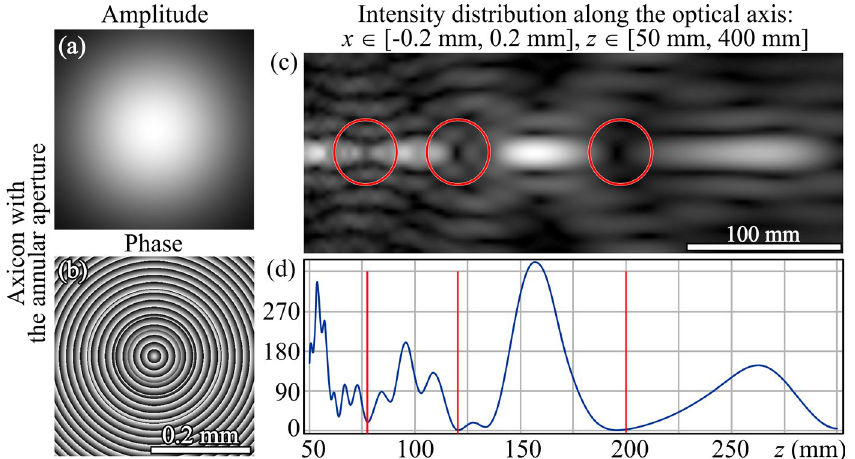
Figure 9. Simulation of the formation of three optical bottles due to phase jumps at radii r 1 s = 0.4 mm, r 1 e = r 2 s = 0.6 mm, r 2 e = r 3 s = 1.0 mm on the axicon under Gaussian beam illumination with σ = 1.3 mm: ( a ) amplitude and ( b ) phase at the input, ( c ) amplitude distribution along the optical axis ( x ∈ [–0.2 mm; 0.2 mm], z ∈ [50 mm; 400 mm]), ( d ) intensity plot on the axis with the corresponding geometric positions of the optical traps z 1 = 80 mm, z 2 = 120 mm, z 3 = 200 mm (marked by red lines). Note, in this case, the positions of the formed shadow regions corresponding to the optical bottles are very close to the geometric-optical positions. This type of apodization